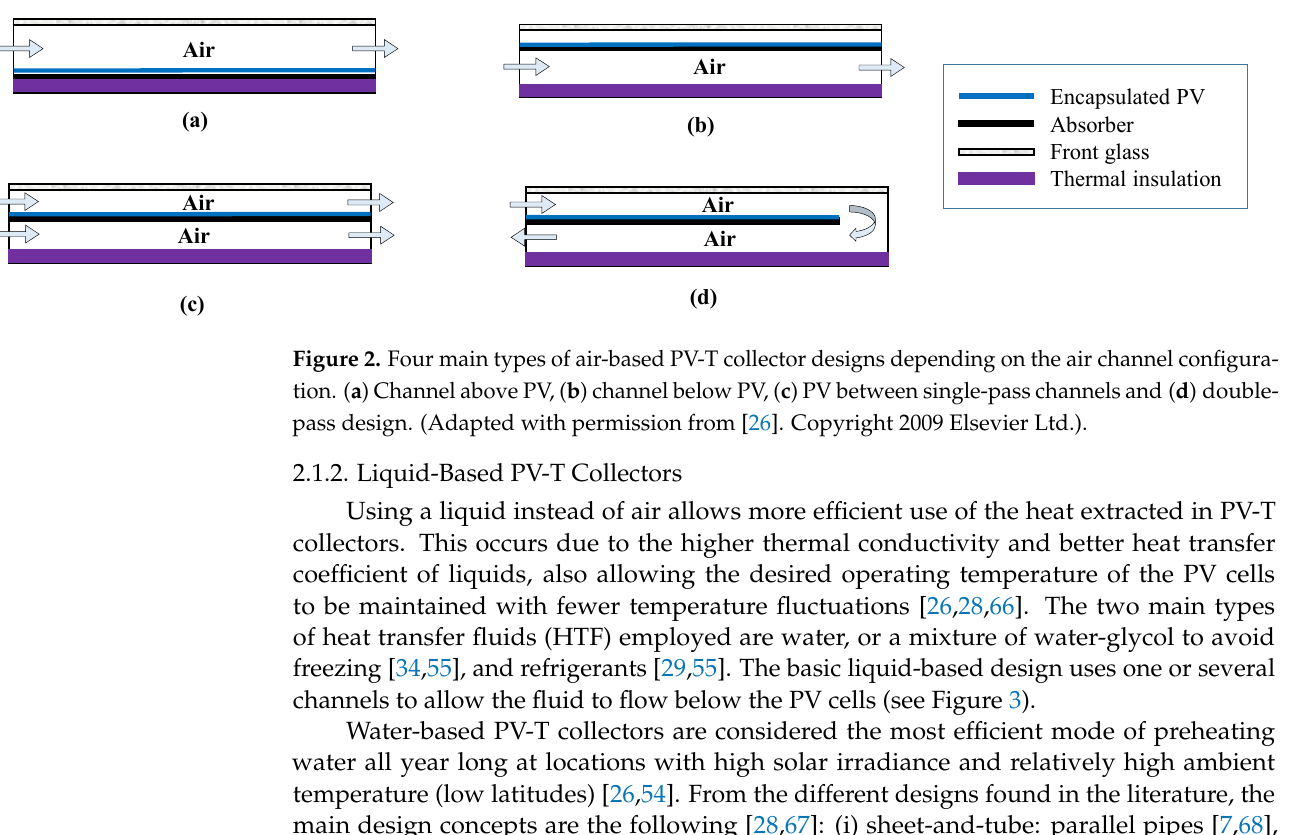
Figure 3. Basic liquid-based PV-T collector designs: ( a ) sheet-and-tube and ( b ) flat-box channel. (Adapted with permission from [26]. Copyright 2009 Elsevier Ltd.).